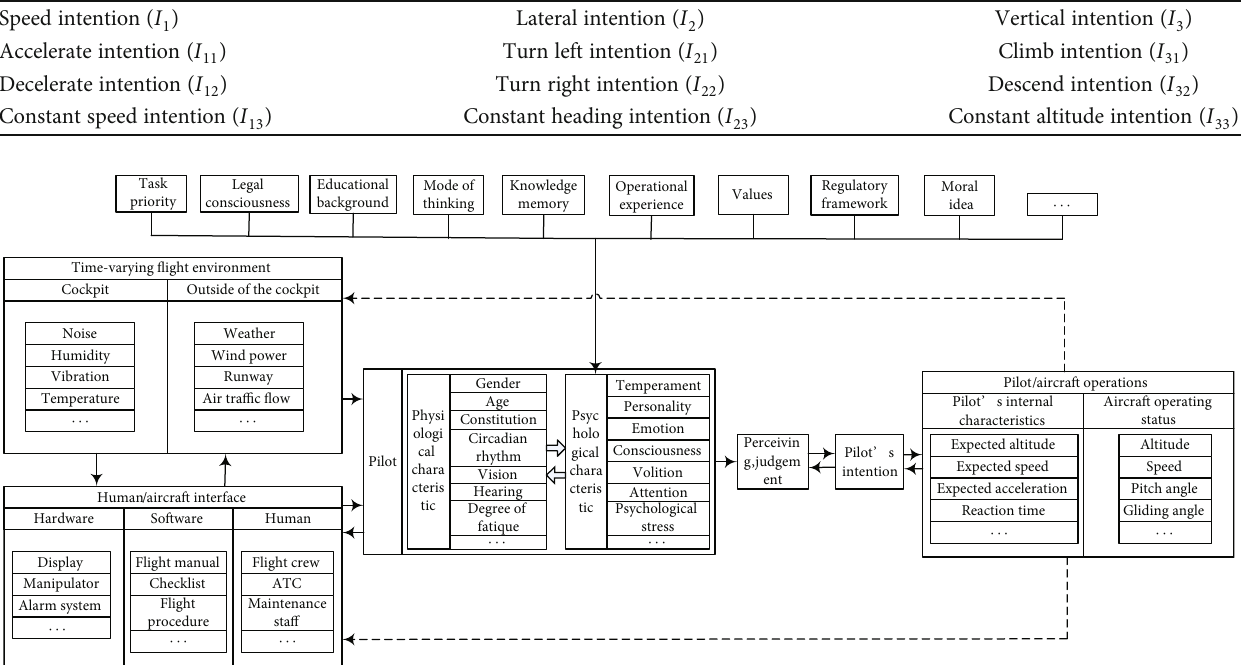
Figure 1: Mechanism of pilot ’ s